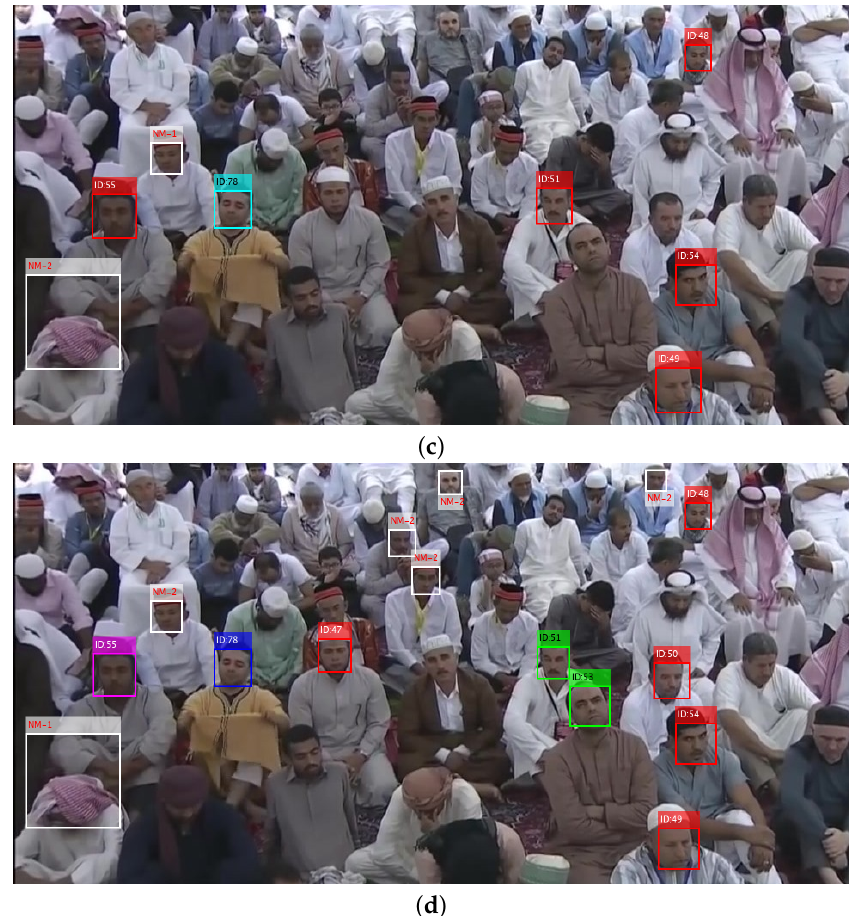
Figure 14. Facial Recognition using CART, HAAR, LBP and Cascade fusion. ( a ) Predicted identi- fication for CART faces; ( b ) Predicted identification for Haar faces; ( c ) Predicted identification for LBP faces; ( d ) Predicted identification for Cascades